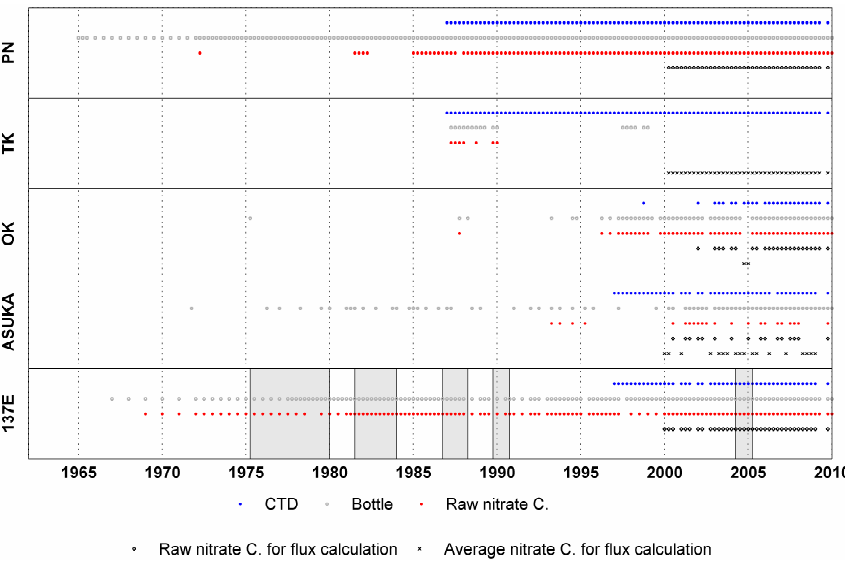
Fig. 2. Data distribution of the five sections. Blue dots denote the CTD data used to calculate velocity; grey circles denote the bottle data for water temperature and salinity; red dots denote the raw nitrate concentration; black circles denote the raw nitrate concentration used to calculate the nitrate flux; black crosses denote the temporally averaged nitrate concentration used to calculate the nitrate flux when the raw nitrate concentration was not available. The grey shading for section 137E denotes the periods when the large meander of the Kuroshio was observed and the data collected during periods were not used in this